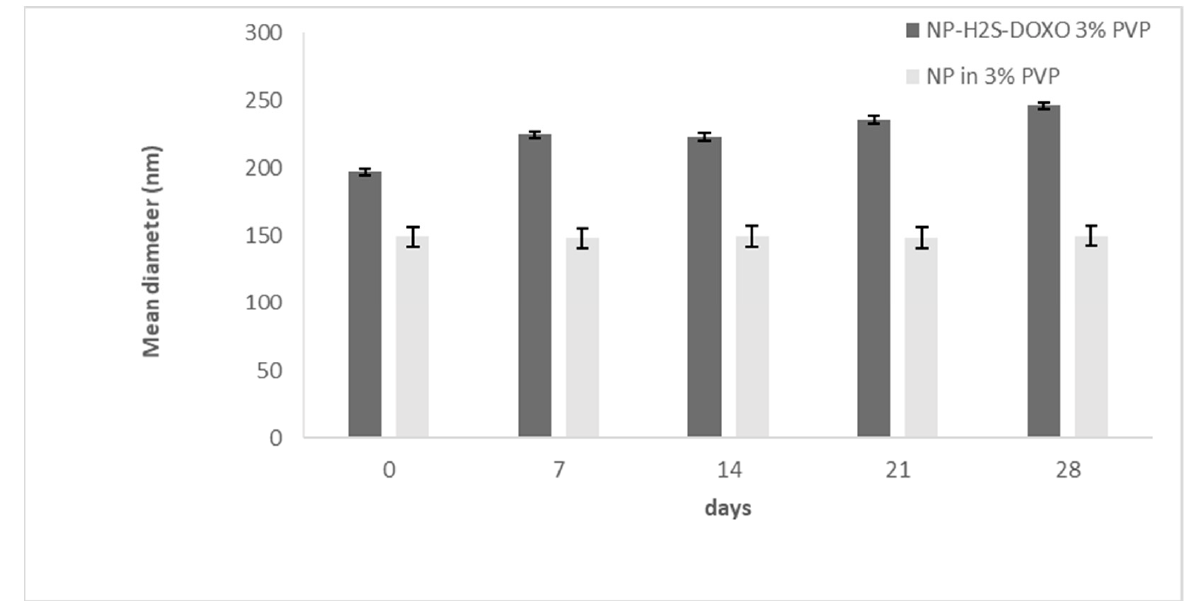
Figure 4. Mean diameter stability of NP-H 2 S-DOXO 3% PVP and NP in 3% PVP over time (28 days). A similar behavior was noted for HA-NP-CTAB, with and without H 2 S-DOXO (Figure 5).